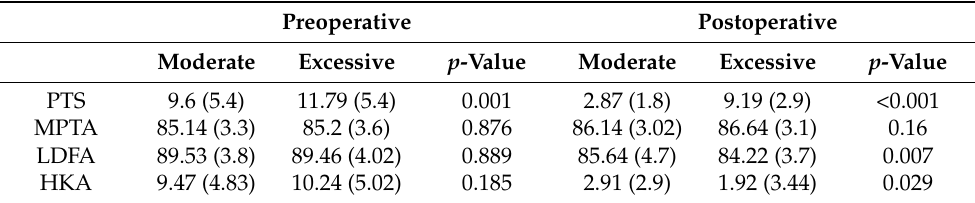
Table 2. Preoperative and postoperative alignment in the moderate and excessive groups. Preoperative